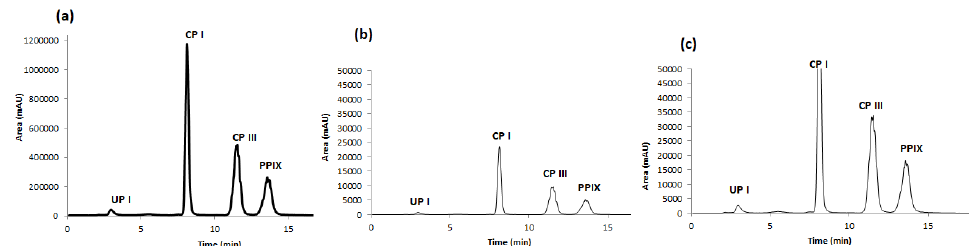
Figure 2. LC-MS chromatograms of: ( a ) standard solution of the porphyrin mixture at 10 µ g mL − 1 , ( b ) LOD of the porphyrin mixture at 0.2 µ g mL − 1 and ( c ) LOQ of the porphyrin mixture at 0.7 µ g mL − 1 . Conditions: stationary phase Luna C18, 5 µ m (size 250 × 0.50 mm 2 ); mobile phase A = 0.2% formic acid in water/B = 50% ACN + 50% MeOH; flow rate 15 µ L min − 1 ; injection volume 5 µ L; detection at 402